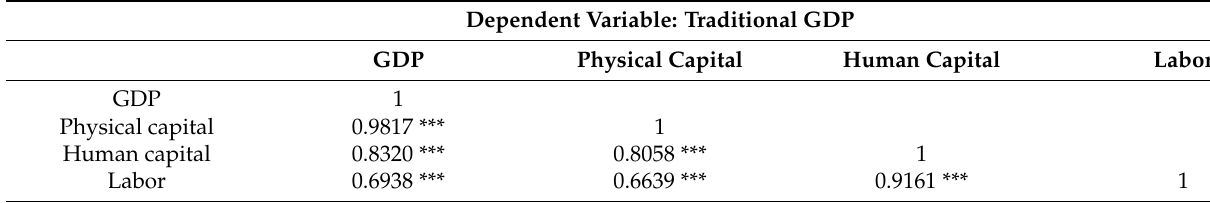
Table 3. Correlation analysis between